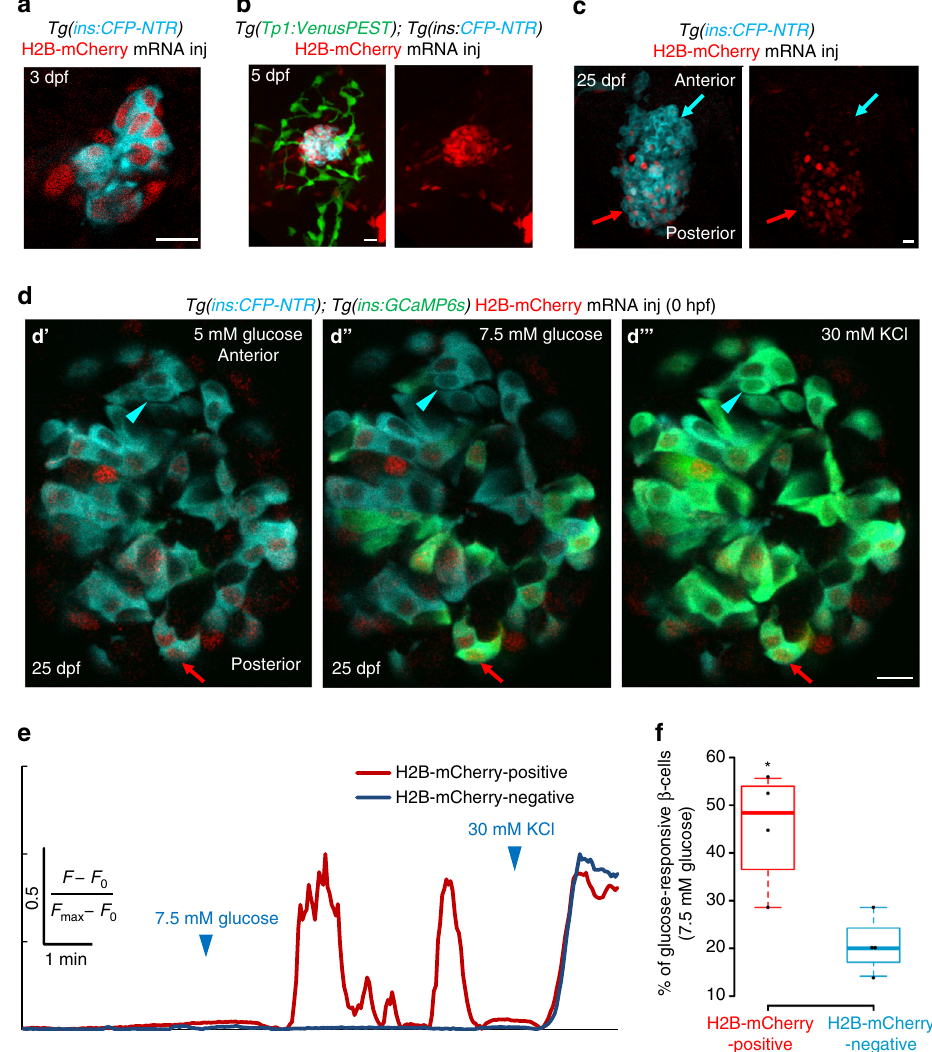
Fig. 5 The embryonic beta-cells are highly glucose-responsive compared to beta-cells differentiating from post-embryonic progenitors. a Primary islets from Tg(ins:CFP-NTR); Tg(GCaMP6s) animals injected with H2B-mCherry mRNA at the one-cell stage and traced until 3 dpf. Beta-cells ( blue ) show uniform expression of H2B-mCherry ( red ) (single confocal plane). b Primary islets from Tg(ins:CFP-NTR); Tg(Tp1:VenusPEST) animals injected with H2B-mCherry mRNA at the one-cell stage and traced until 5 dpf. Beta-cells ( blue ) show strong expression of H2B-mCherry ( red ), whereas the post-embryonic progenitors ( green ) are H2B-mCherry-negative (confocal projection). c Primary islets from Tg(ins:CFP-NTR); Tg(GCaMP6s) animals injected with H2B- mCherry mRNA at the one-cell stage and traced until 25 dpf. The H2B-mCherry-negative beta-cells localize preferentially within the anterior regions of the islet ( blue arrow ), whereas the H2B-mCherry-positive cells occupy the posterior ( red arrow ) (confocal projection). d Ex vivo live imaging of islets from Tg (ins:GCaMP6s); Tg(ins:CFP-NTR) animals at 25 dpf injected with H2B-mCherry mRNA at the one-cell stage. Beta-cells ( blue ) were stimulated with 5 (basal) d ′ and 7.5 mM D -glucose d ′′ followed by depolarization via addition of 30 mM KCl d ′′′ while monitoring GCAMP6s- fl uorescence ( green ). A red arrow indicates an H2B-mCherry-positive beta-cell, whereas the blue arrowhead indicates an H2B-mCherry-negative beta-cell. e Normalized GCaMP6s fl uorescence intensity trace. The H2B-mCherry-positive cell ( red trace , red arrow in c ) exhibits oscillating GCaMP6s- fl uorescence in response to glucose, while the H2B-mCherry-negative cell ( blue trace , blue arrowhead in c ) only responds to depolarization with KCl. f Tukey style boxplot showing that a higher proportion of the H2B-mCherry-positive beta-cells respond to glucose, as compared to the H2B-mCherry-negative beta-cells. A cell was considered as H2B-mCherry-negative if the mean fl uorescence intensity was similar to background ( n = 46 H2B-mCherry-positive and 44 H2B-mCherry-negative cells from four islets) (unpaired two-tailed t -test, * p < 0.05). Scale bars , 10 µ divide and contribute to increasing the beta-cell mass. As